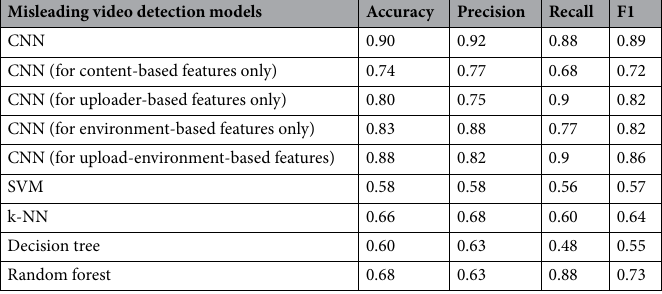
Table 2. Comparison of different detection models.